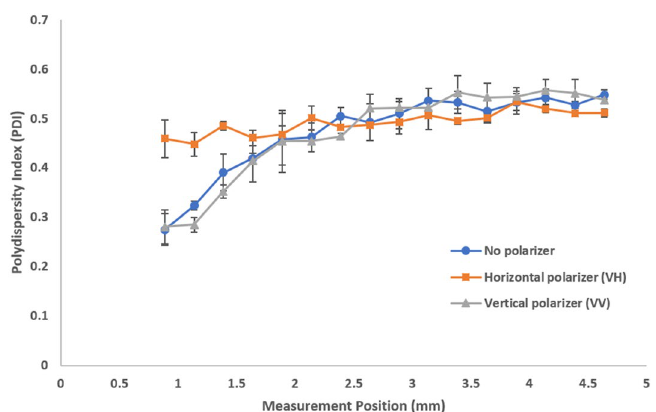
Figure 7. Polydispersity index (PDI) as a function of measurement position shows the effects of multiple scattering with different polarizer configurations for stock milk. The effects of multiple scattering are most evident at positions closer to the cell